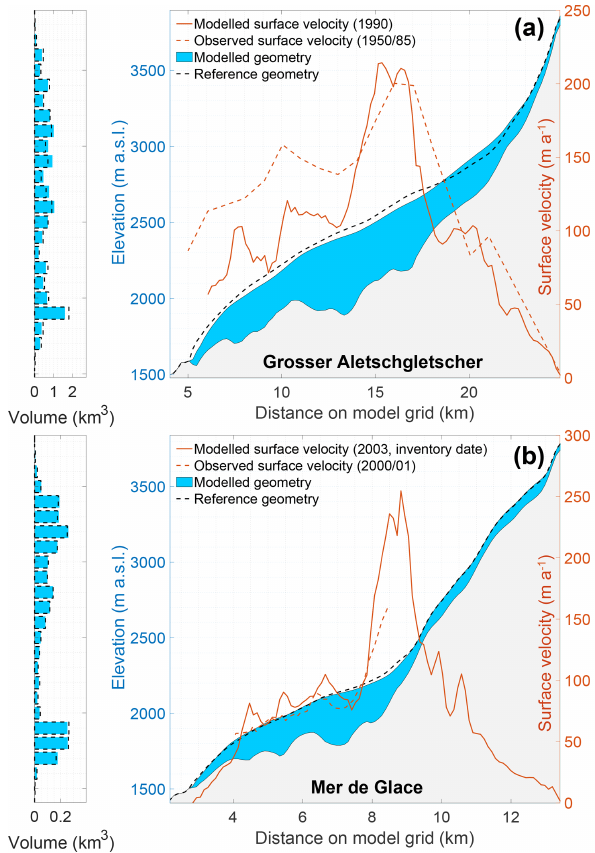
Figure 5. Comparison between reference and modelled (i) glacier geometry, (ii) volume–elevation distribution and (iii) surface veloc- ities for Grosser Aletschgletscher (a) and Mer de Glace (b) . Refer- ence geometries and volume–elevation distribution are at inventory date (2003) and based on Huss and Farinotti (2012). Observed sur- face velocities for Grosser Aletschgletscher are from Zoller (2010) and correspond to 1950/1985 point averages, while observed ve- locities for the Mer de Glace are derived from 2000/2001 SPOT imagery (Berthier and Vincent,